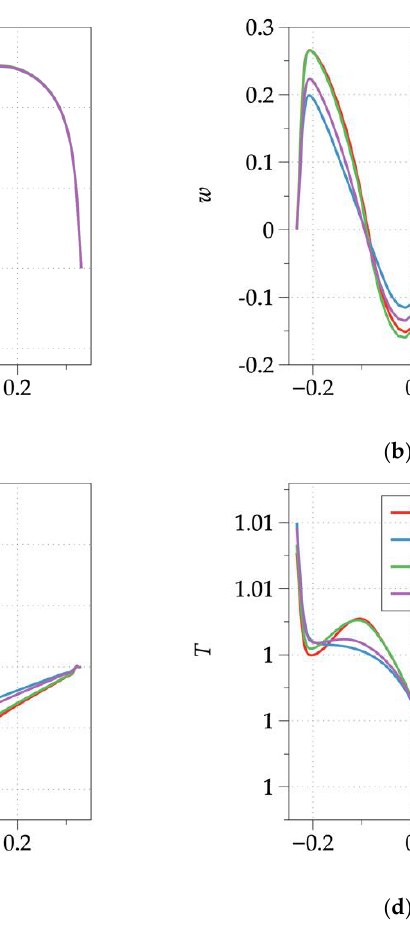
Figure 7. Distributions of the relative Nusselt numbers Nu / Nu pl ( a , b ) and the transverse strip-averaged relative Nusselt numbers Nu m / Nu mpl ( c , d ) in the middle longitudinal ( a , c ) and transverse ( b , d ) sections of the dimpled walls for the different standard SST models and the modified Menter SST models. Red line—Menter 1993 SST model, Blue line—Menter 2003 SST model, Green line—Menter SST model corrected according to RLI, and Purple line—Menter SST model corrected according to SM.